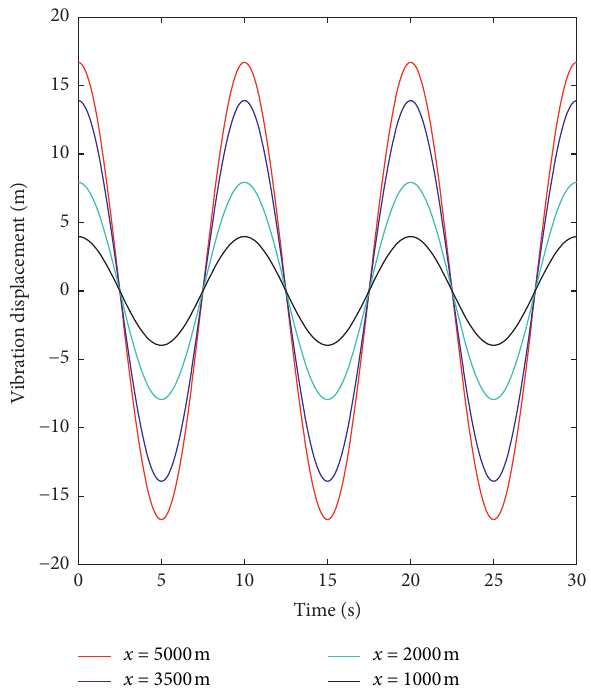
Figure 7: Longitudinal vibration displacement based on MATLAB.